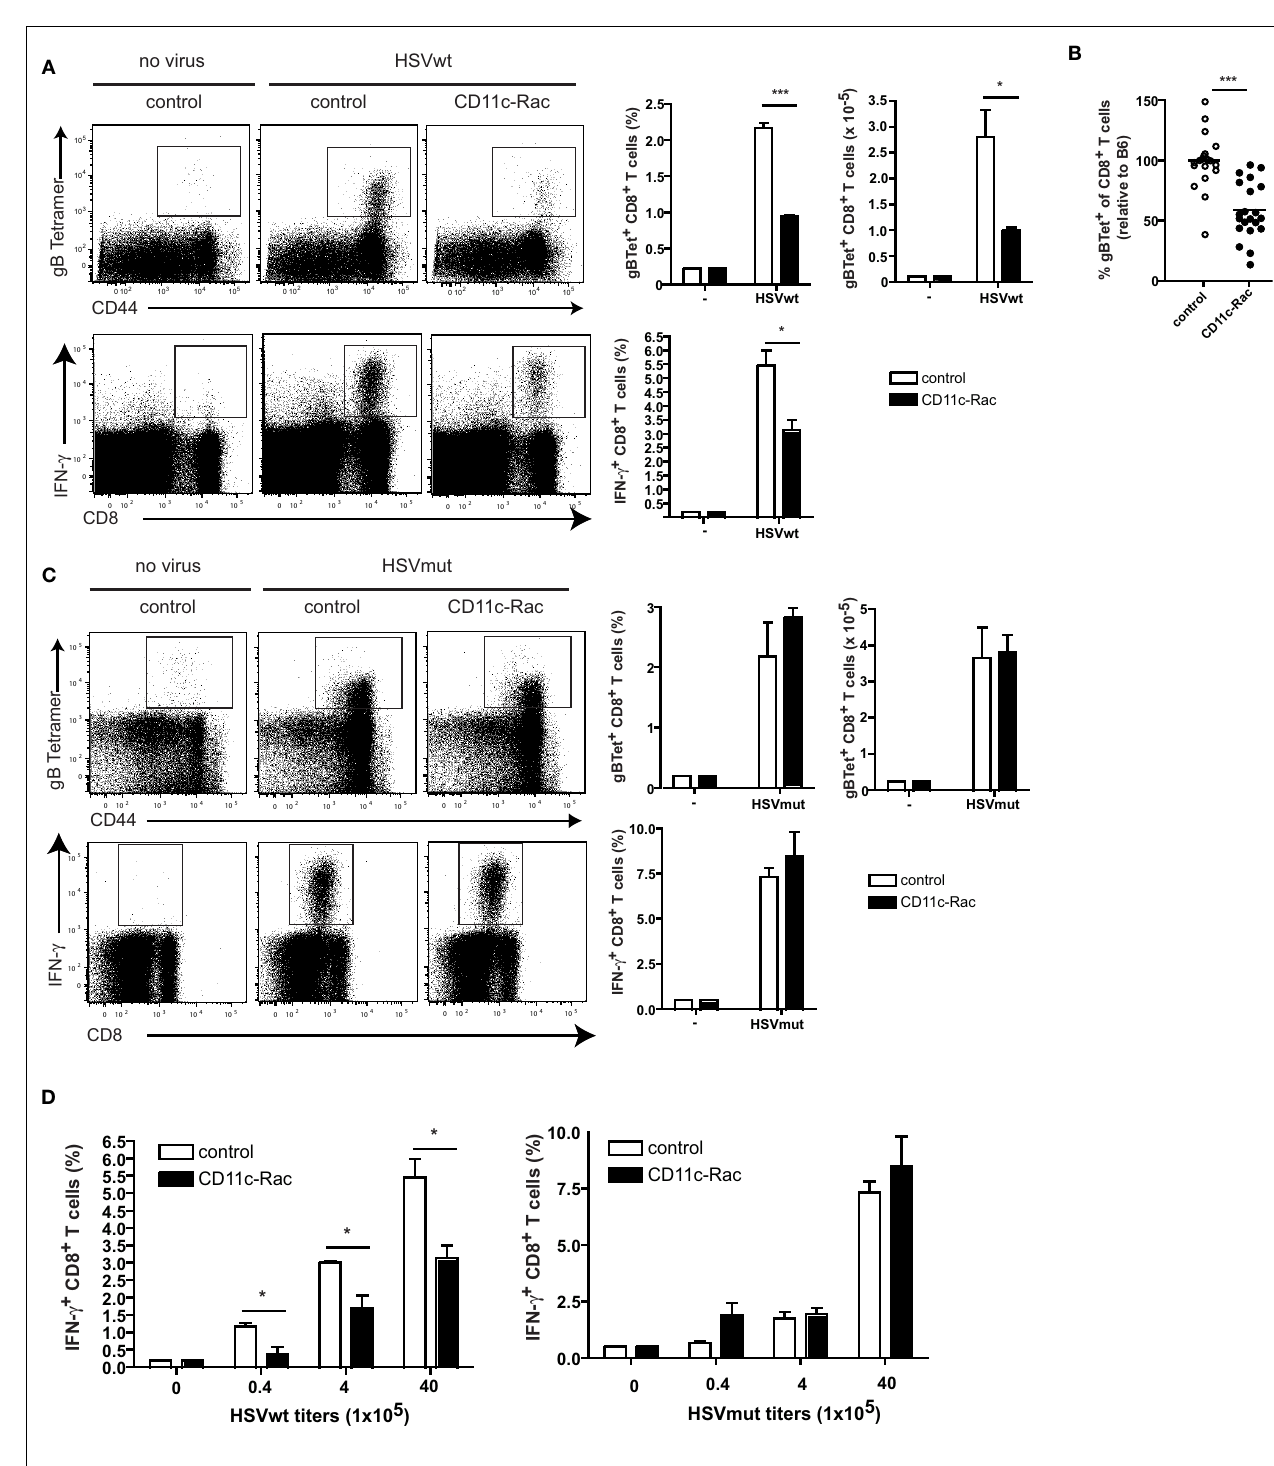
upper panel: *** P < 0.0001; * P = 0.0284; a, lower panel * P = 0.0243. (B) Pooled data from seven experiments ( n = 3 mice per group, total n = 21) are displayed as percent of control (C57BL/6).The mean of each control group was set to 100% and the data from the CD11c-Rac-groups were calculated relative to the respective control group (*** P = 0.0001). (D) Mice were immunized with the indicated amounts of HSVwt or HSVmut. Analyses were performed as described in (A) . HSVwt 0.4 × 10 5 , * P = 0.0221; 4 × 10 5 , * P = 0.0223; 40 × 10 5 , * P = 0.0243; One out of two experiments with similar outcome is shown ( n = 3 mice per